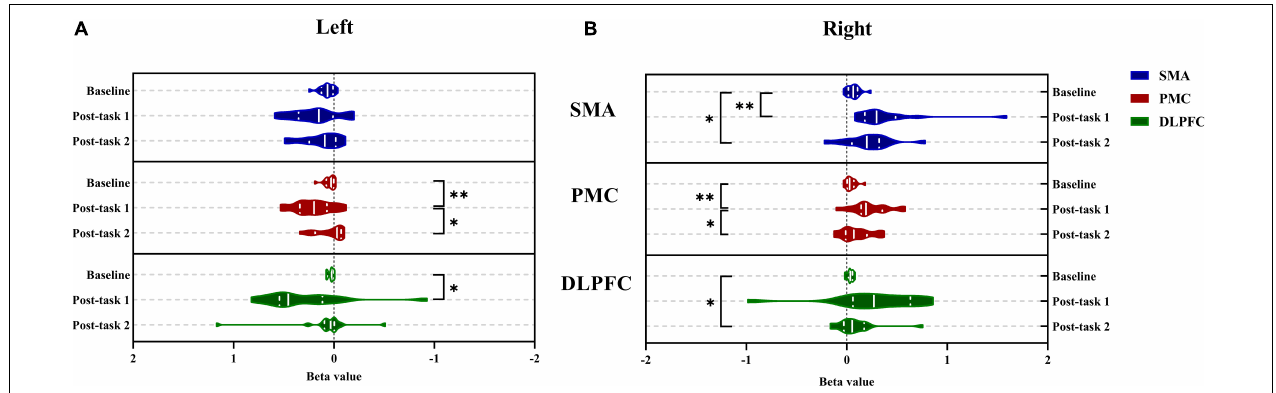
FIGURE 6 | Comparison between the left and right brain of bate value in different regions of interest during Baseline, Post-task 1 and Post-task 2. (A) The left brain; (B) the right brain. ∗ P < 0.05 and ∗∗ P < 0.01. SMA, supplementary motor cortex; PMC, premotor cortex; DLPFC, dorsolateral prefrontal cortex; Post-task 1: after the NIVR-Exergame task; Post-task 2, after the resistance band stretching task.